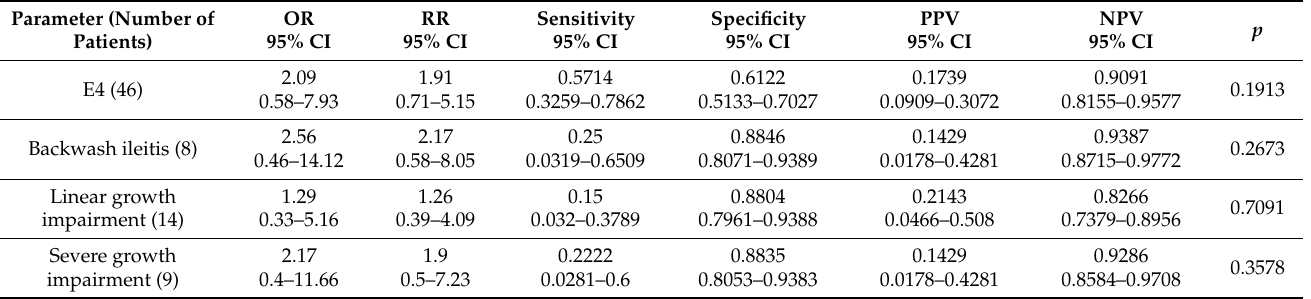
Table 5. UC—Paris classification parameters. In brackets the number of patients presenting with each